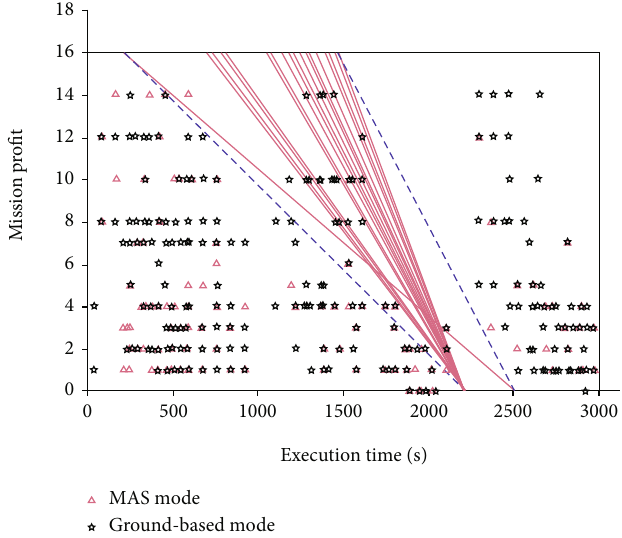
Figure 7: The boundaries and envelopes of the clustering result of the MAS mode and the ground-based mode.